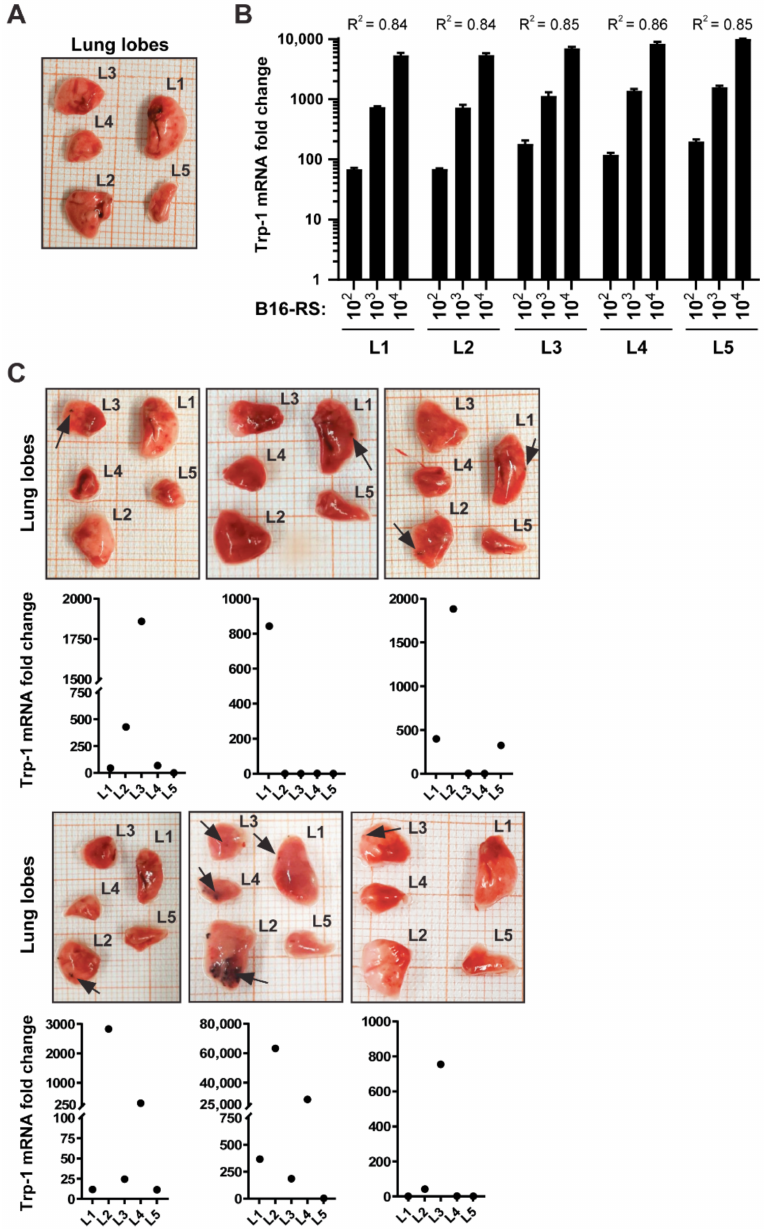
Figure 2. Trp-1 transcript levels correlated with metastatic burden in the lungs of experimental mice in a syngeneic mouse B16 model. ( A ) Representative image of a murine lung with isolated lung lobes: left lobe (L1), right caudal lobe (L2), right cranial lobe (L3), right middle lobe (L4), and accessory lobe (L5). Note that the arrangement of the lobes reflects the anatomical position, whereas the numbering corresponds to the size of the lobes, from largest to smallest. ( B ) qRT-PCR analysis of Trp-1 in samples containing 1 × 10 2 –1 × 10 4 B16-RS cells admixed with individual lobes (L1–L5). Data were normalized to RPLP0 and to the mean Trp-1 signal in lobes without B16-RS cells. The graph shows mean Trp-1 expression + SEM, n = 3. R 2 : coefficient of determination. ( C ) B16-RS cells (1 × 10 5 ) were injected subcutaneously into syngeneic mice ( n = 6), and treated with either DMSO as a vehicle control (3 animals; top row) or RSL (3 animals; bottom row). The mice were sacrificed once the tumors reached a diameter of 2 cm in one dimension. Lungs were explanted and inspected for visible metastases. Trp-1 expression in the individual lobes was determined by qRT-PCR. Lung lobes with visible metastases (black arrows) are shown together with the corresponding Trp-1 expression in each of the five individual lung lobes (labelled L1 to L5, as in panel A), detected by qRT-PCR. Data were normalized to RPLP0 and to the mean Trp-1 signal in lobes of non-tumor-bearing